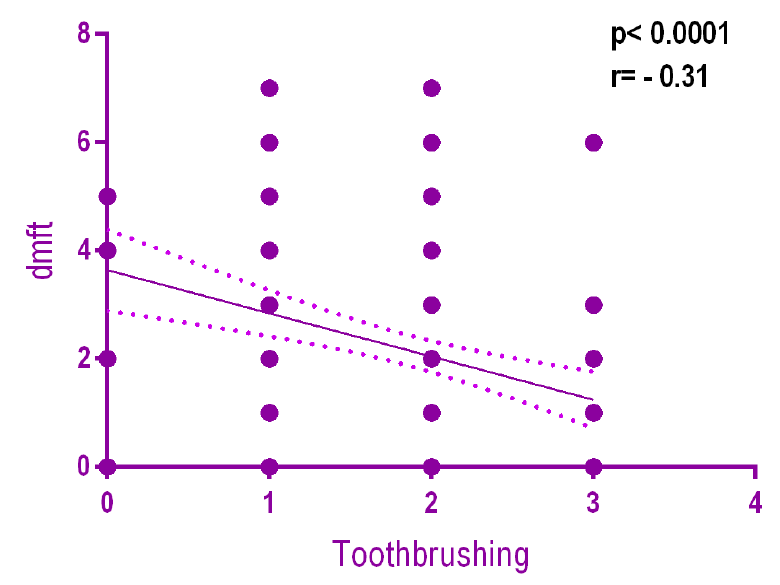
Figure 4. Relationship between dmft and toothbrushing frequency. There is a weak but statistically significant negative relationship ( r = − 0.41, p < 0.0001) between DMFT and the frequency of toothbrushing. The more frequent the toothbrushing, the lower the DMFT (Figure